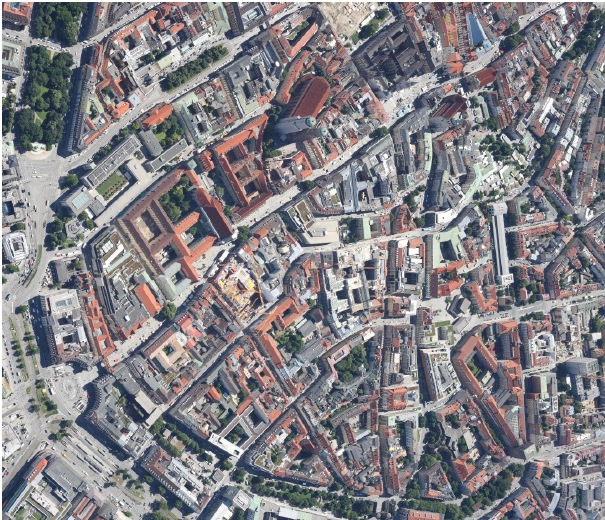
Figure 6: Aerial image data - inner city of Munich (Marienplatz)